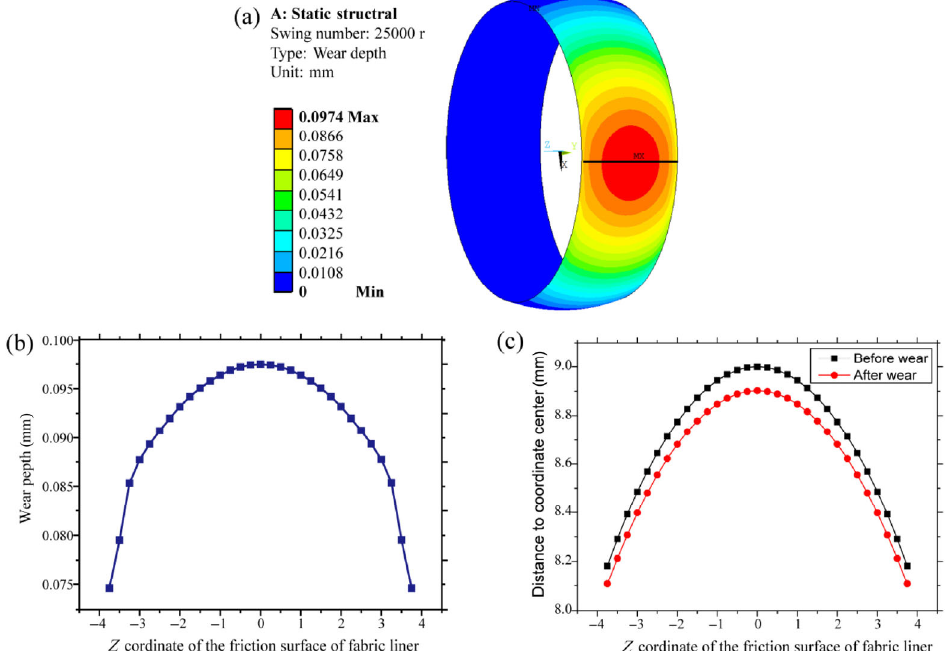
Fig. 7 Wear depth distributions on the friction surface of the fabric liner: (a) wear morphology obtained from simulation, (b) wear depth along the z direction, and (c) comparison of the friction surface of fabric liner before and after